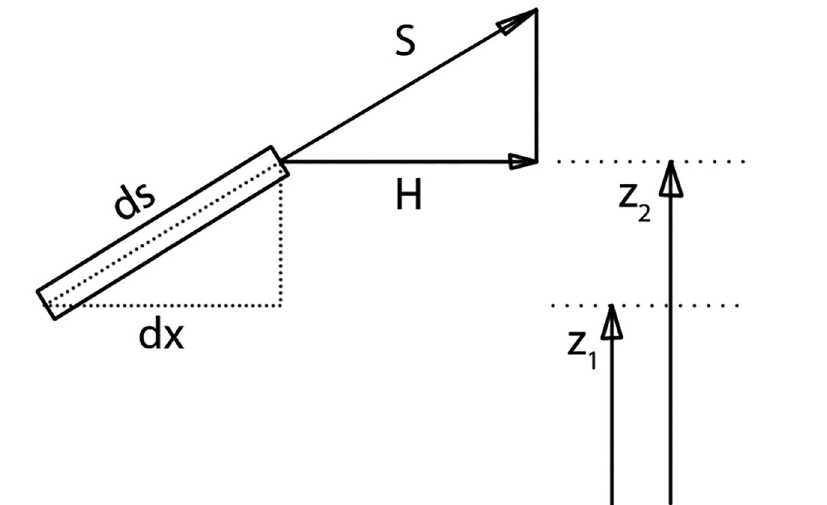
Fig 8. Display of an infinitesimal cable